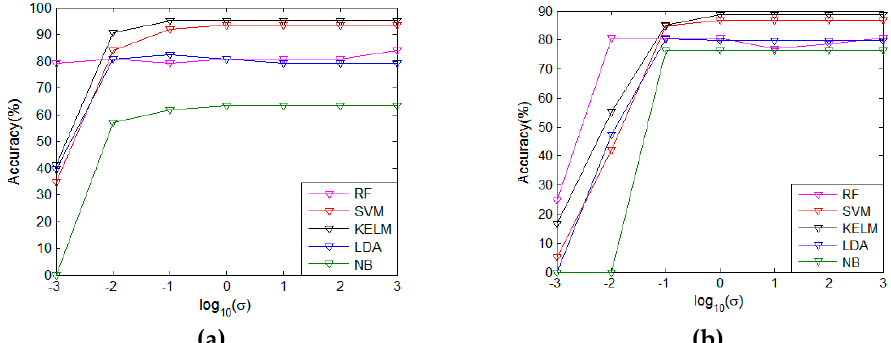
σ ): ( a ) Our own dataset. ( b )